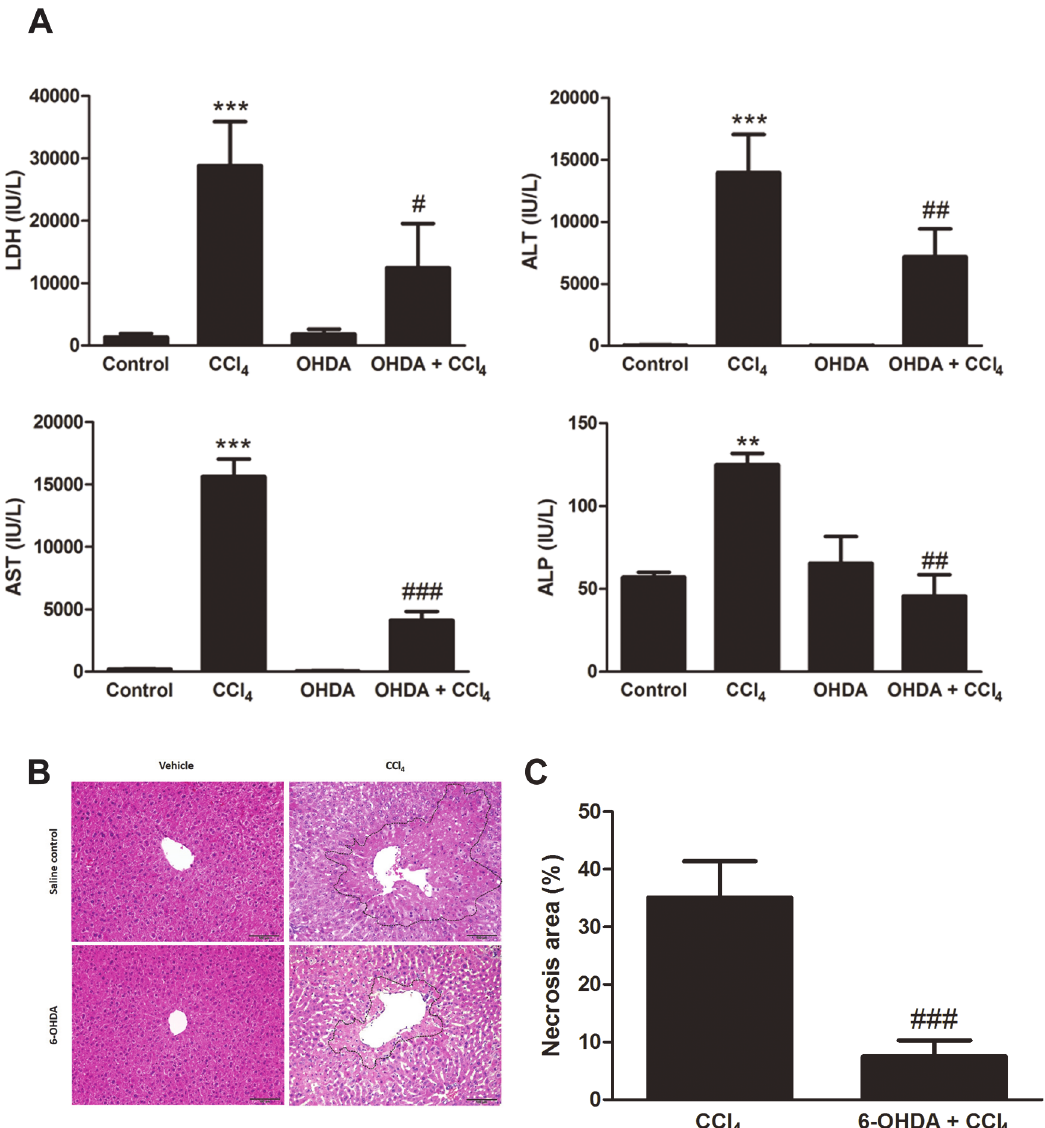
Fig 3. Absence of the sympathetic nervous system attenuated CCl 4 -induced hepatotoxicity. (A) Serum isolated from whole blood was used to determine lactate dehydrogenase (LDH), alanine aminotransferase (ALT), aspartate aminotransferase (AST), and alkaline phosphatase (ALP) levels. Bars are means ± SD, n = 6 mice per group. ( *** p < 0.001 vs. control, # p < 0.05 vs. CCl 4 , and ## p < 0.01 vs. CCl 4 ) (B) Liver sections after CCl 4 administration were stained with hematoxylin and eosin, 200× magnification. Scale bar = 100 μ m. (C) The semi-quantitative data of hepatocellular necrosis area showed sympathetic denervation resulted in lower necrosis area ( ### p < 0.001 vs. CCl 4 ). Images are representative of n = 6 mice per group.